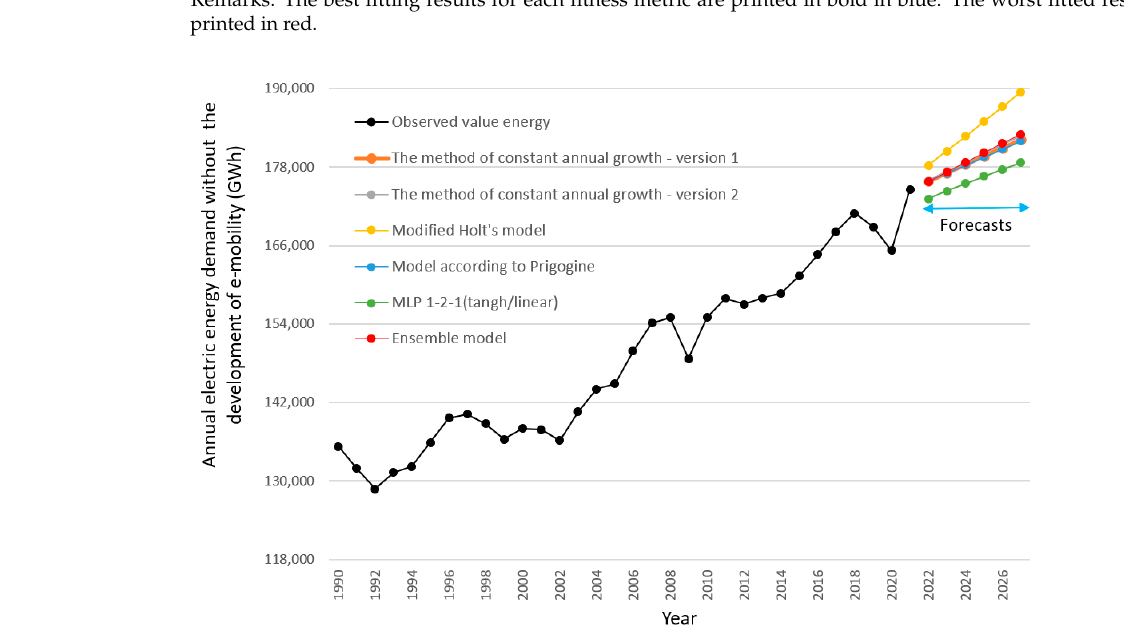
Table 3. Performance metrics for the forecast values of annual power demand in Poland within the model’s parameter estimation range.